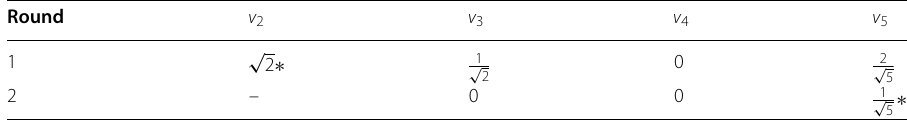
Table 4 Running process of greedy with diversity algorithm Round v 2 v 3 v 4 v 5 1 1 √ 2 0 2 √ 2 √ 5 ∗ 2 – 0 0 1 √ 5